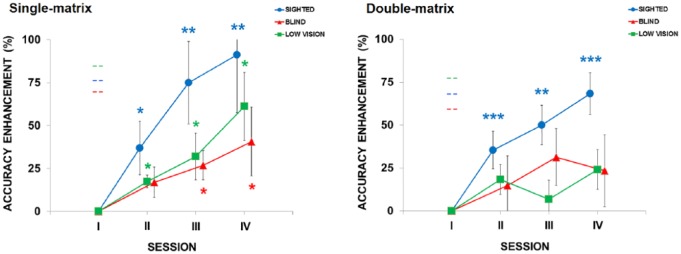
Accuracy results. Left panel: Normalized accuracy enhancement (SEM indicated as whiskers) across sessions in the single-matrix task. Color-coded asterisks indicate a significantly larger accuracy enhancement for that training-session relative to the baseline (*p < .05; **p < .01). Color-coded dashed lines represent the accuracy at the baseline for each group after correcting for the level of difficulty (number of targets). Right panel: Normalized accuracy enhancement (SEM indicated) across sessions in the double-matrix task. Blue asterisks indicate a significantly larger accuracy enhancement relative to the baseline in the sighted group (**p < .01; ***p < .001). Color-coded dashed lines represent the accuracy at the baseline for each group after correction for level of difficulty (number of targets).